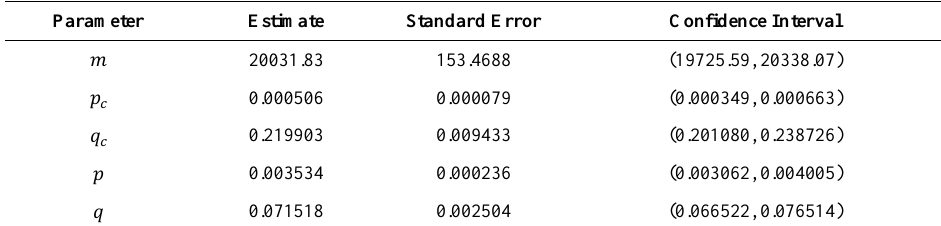
Table A4. Veneto. Estimates, asymptotic standard errors and 95% mCIs for the parameters of the DMP (8).